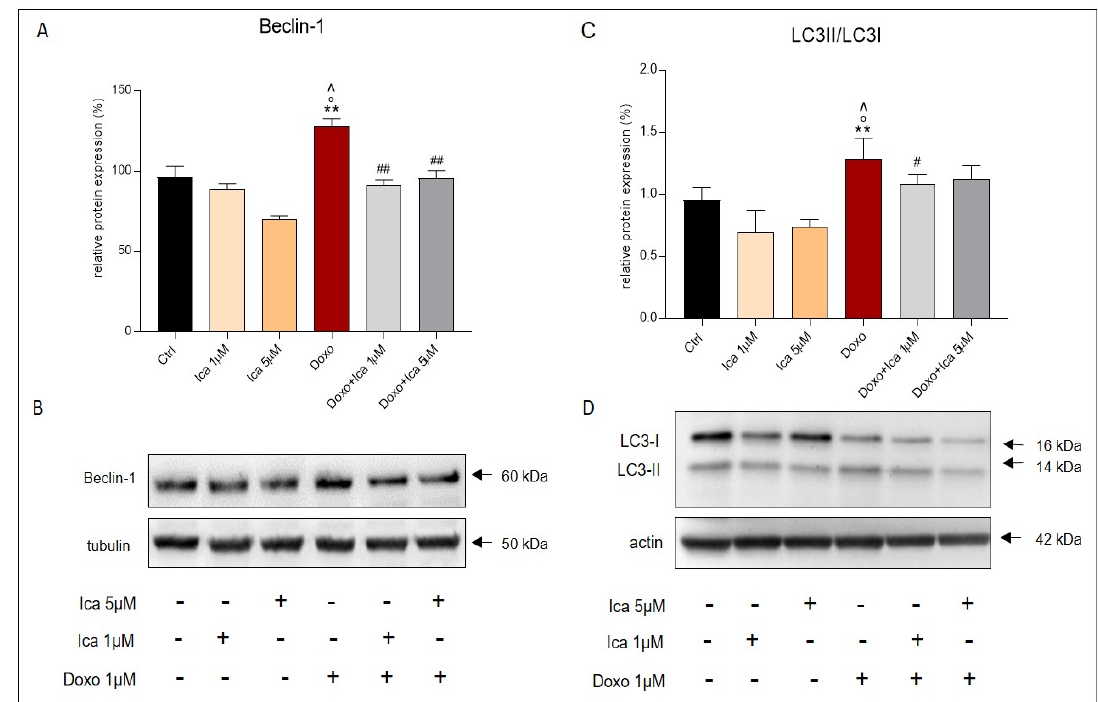
Figure 9. The effect of Ica on the pro-autophagic markers Beclin-1 and LC3. Treatment with Doxo alone significantly increased the expression levels of Beclin-1 ( A ) and LC3II/LC3I ratio ( C ) in H9c2 cells. Pretreatment with Ica at both concentrations used inhibited the proautophagic pathway when compared to H9c2 cells treated with Doxo alone. ( B , D ) Representative images of western blot analysis. Three independent Western Blots were quantified by densitometry. The protein expression of Beclin-1 and LC3II/LC3I were normalized with respect to the corresponding tubulin or actin signals of the appropriate samples and expressed as a percentage. Data are expressed as mean ± S.E.M. ** p < 0.01 vs. Ctrl; ° p < 0,05 vs. Ica 1uM; ^ p < 0.05 vs. Ica 5 μ M; # p < 0.05 vs. Doxo; ## p < 0.01 vs. Doxo; Mann Whitney test ( n = 3).